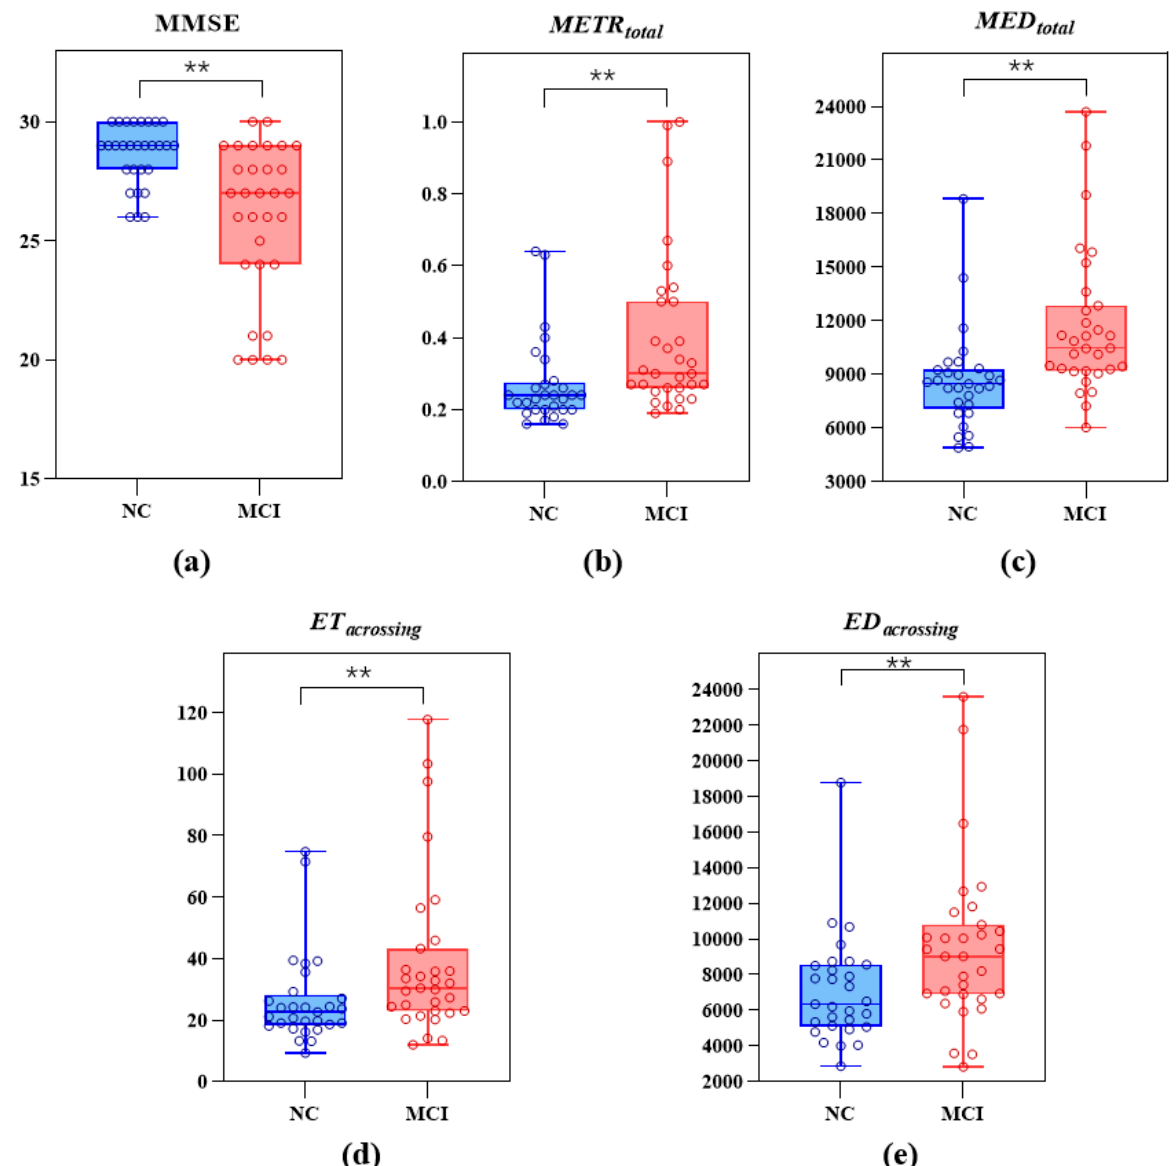
Figure 6. Distribution of ( a ) MMSE scores of the NC and MCI groups with basic education, ( b ) METR total values of the NC and MCI groups with basic education, ( c ) MED total values of the NC and MCI groups with basic education, ( d ) ET crossing values of the NC and MCI groups with basic education, ( e ) ED crossing values of the NC and MCI groups with basic education; (** indicates a significant difference between the two groups, at p < 0.01).